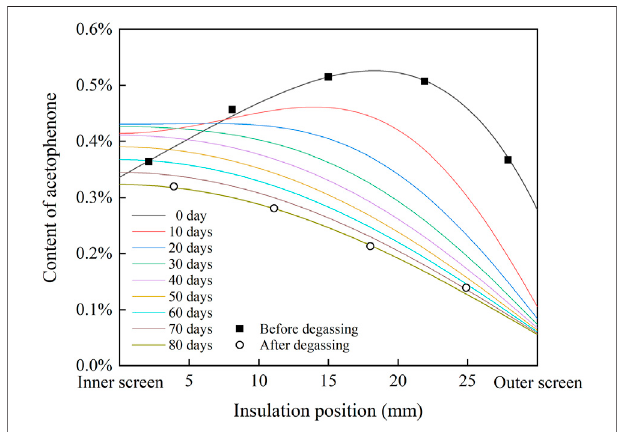
FIGURE 5 | Radial distribution of acetophenone in cable insulation modeling by the phase fi eld in the single well model.